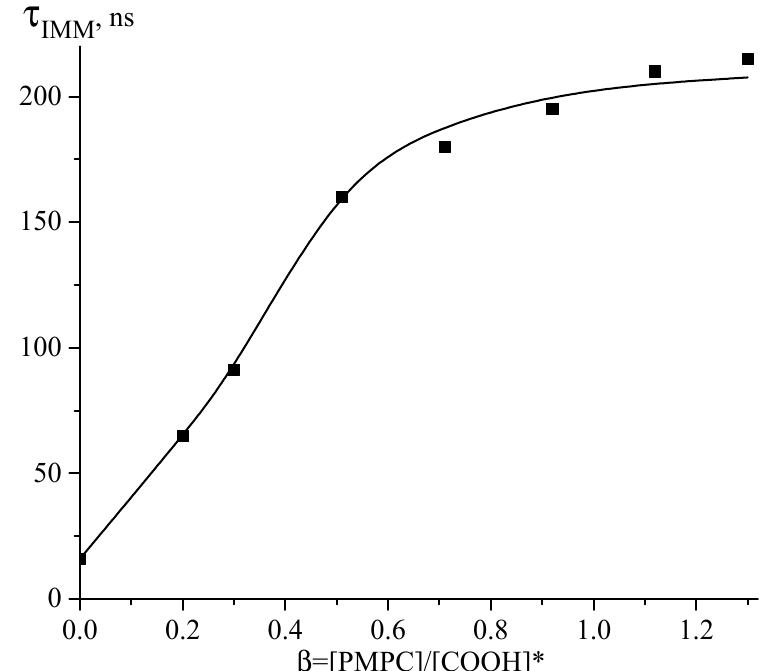
Figure 6. Dependence of τ IMM of PAA* on the ratio β = [PMPC]/[COOH]*. Relaxation times τ IMM increase from 16 to 220 ns, i.e., by more than one order of magnitude. The maximum values of τ IMM are reached at β ~ 0.9; i.e., 10 PAA units per ~9 PMPC units are involved in complex formation. Comparing this complex with the PMPC-PMAA system shows significant differences in the maximum τ IMM values and composition of associates. These differences in the τ IMM values of polyacids included in the complex (230 ns for PAA and 780 ns for PMAA) and the number of COOH groups per 1 MPC unit are caused by the influence of α -methyl groups on the structure of the associate. It is known that, in aqueous solutions, local compact structures appear in the linear PMAA macro- molecules due to interaction between an α -methyl groups; accordingly, lower intramolec- ular mobility of PMAA chains is registered (as compared to that of PAA chains) [29,30] Thus, it may be supposed that hydrophobic interactions between the α -methyl group of PMAA and non-polar groups of the PMPC unit play an essential role in forming the PMPC-PMAA complex. The possible structure of the fragment of the complex between PMPC and non-ion- ized PAA or PMAA is presented in Scheme 2: